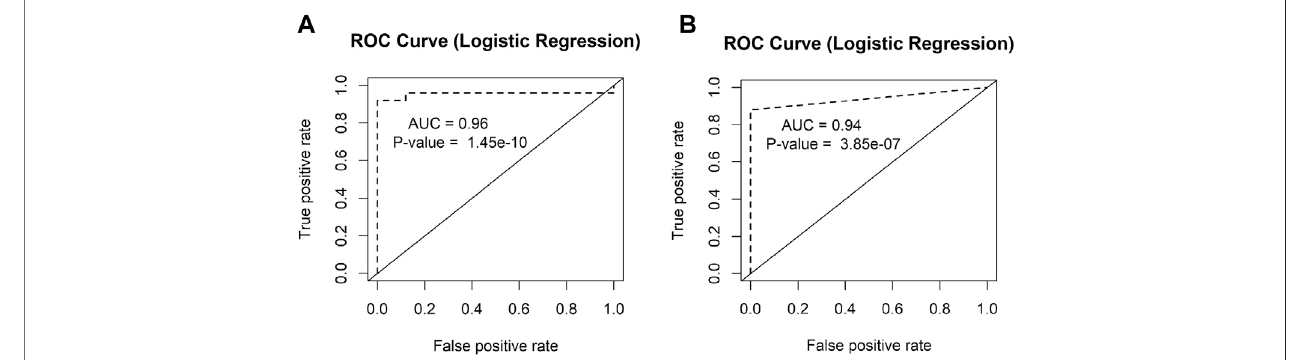
FIGURE 8 | ROC analysis of the candidate circRNAs. The AUC values of the ROC curves of (A) circCEACAM5 and (B) circCOL1A1 represented the accuracy of these circRNAs in distinguishing GC and normal patients.